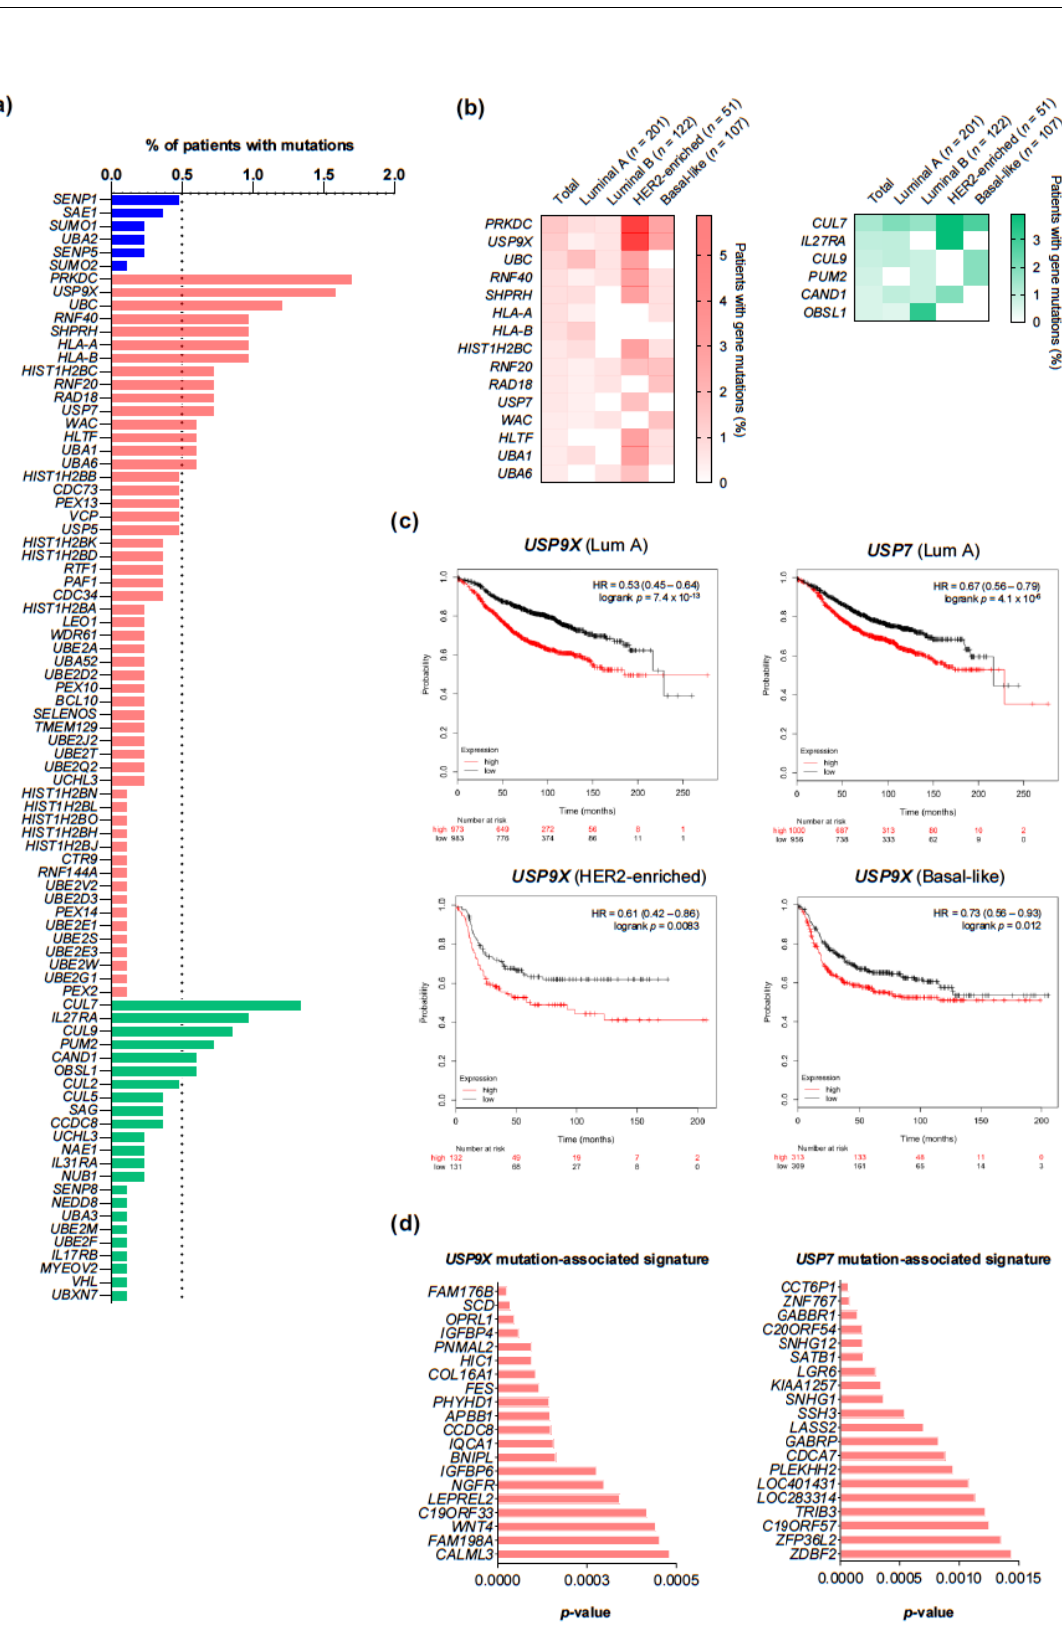
Figure 7. Mutational landscape and prognostic implications. ( a ) Frequency of gene mutations in breast cancer patients from the TCGA dataset. ( b ) Distribution of the frequencies of gene mutations over 0.5% across intrinsic subtypes. Population is limited to those patients in which the intrinsic subtype is available in cBioPortal for stratification. ( c ) Significant associations between the transcriptomic signatures of USP9X and UP7 mutations and overall survival across intrinsic subtypes. ( d ) Top USP9X and USP7 -associated transcriptomic signature components, sorted by p -value.